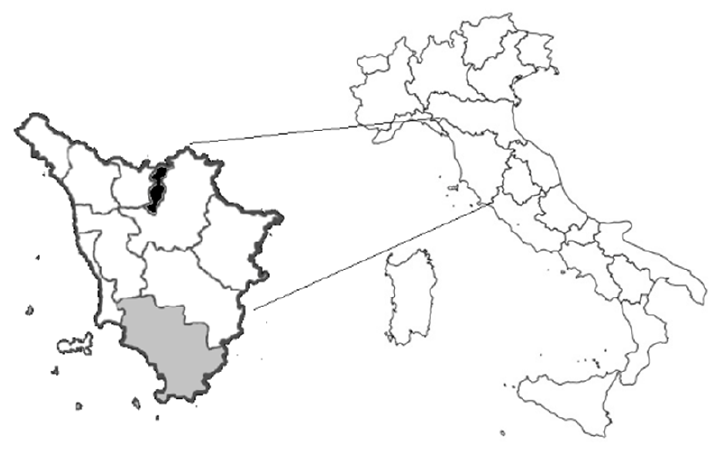
Figure 1. Map of sampling area: Detailed map of Tuscany; black and grey area represent the Prato and Grosseto provinces, respectively.